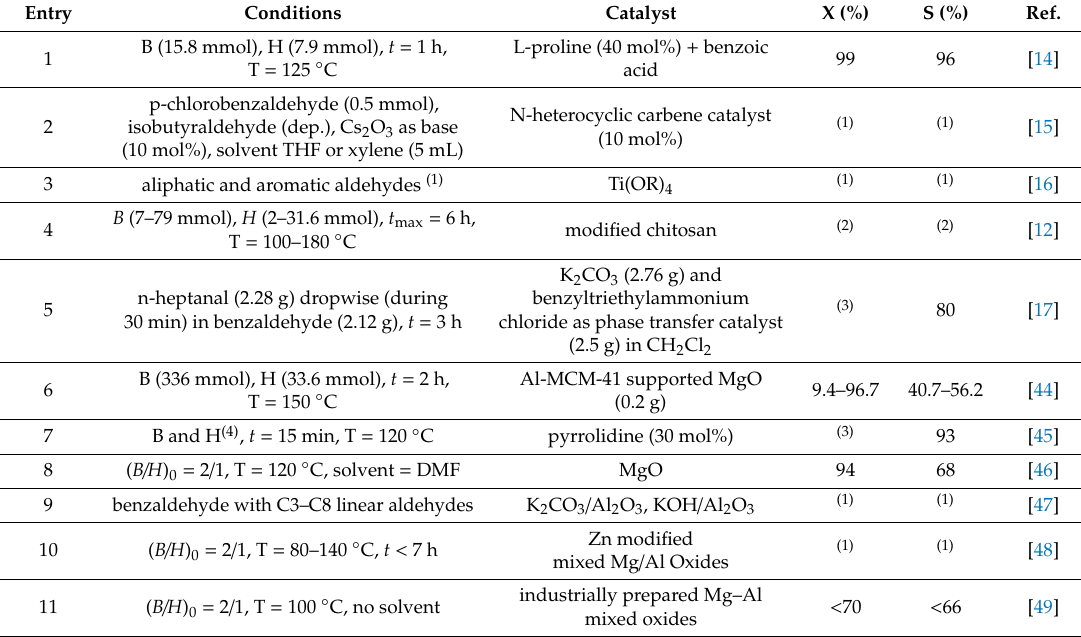
Table A1. Reported experimental conditions for jasmin aldehyde production. B (benzaldehyde),